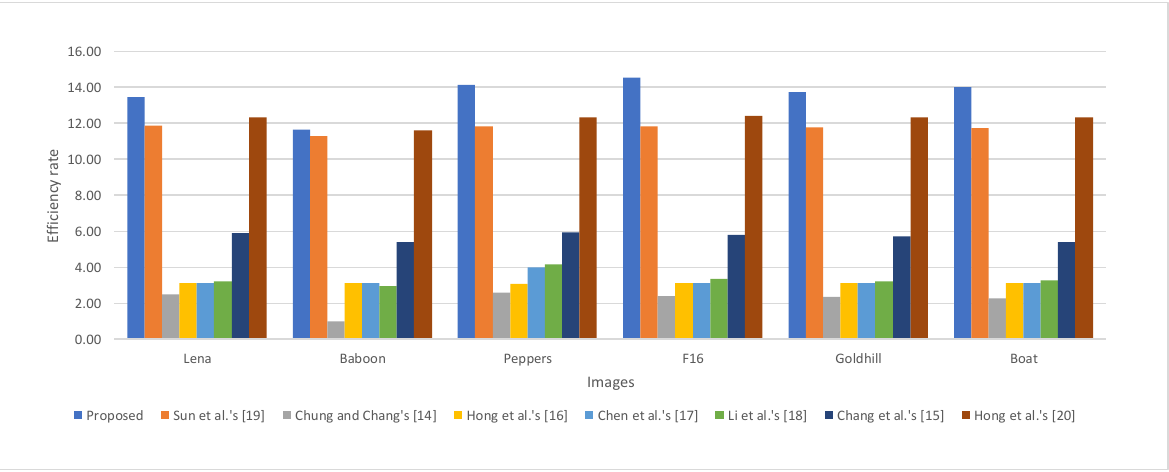
Figure 9. Comparison of efficiency rate between the proposed scheme and seven previous schemes [14–20].